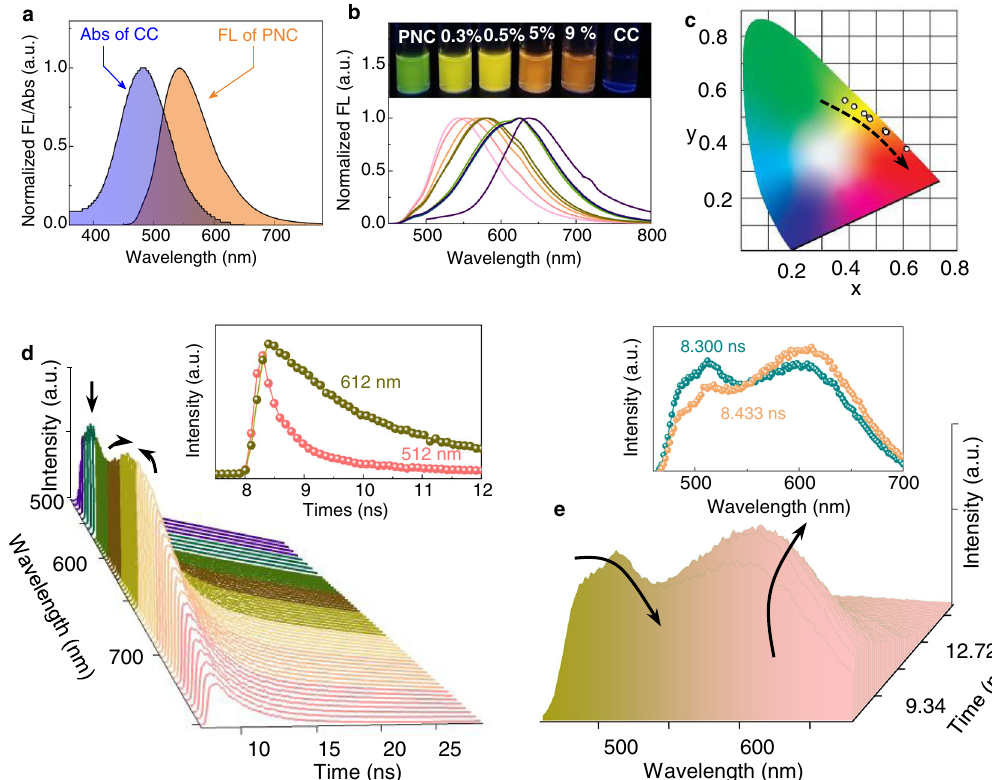
Fig. 3 Optical properties of assemblies upon THF/H2O = 1/9 (v/v). a Normalized spectrum overlaps of donor emission (10 − 4 M) and acceptor absorption (10 − 4 M, excited at 430 nm). b Normalized fl uorescent spectra of PNC (10 − 4 M) with various amount of CC (from left to right: 0, 0.1, 0.3, 0.5, 0.7, 3, 5, 7, 9 mol%, excited at 430 nm) and CC (9 × 10 − 6 M, excited at 480 nm). Insets show the pictures under 365 light irradiation (from left to right: 0, 0.3, 0.5 mol%, 5, 9 mol% and CC) and c corresponding CIE coordination evolution. d Fluorescent decay curves of PNC/CC ([CC] = 5 × 10 − 7 M). Inset shows fl uorescent decay curves of PNC/CC at emission wavelengths of 512 and 612 nm. e TRES of PNC/CC ([CC] = 5 × 10 − 7 M). Inset shows TRES comparison at 8.300, 8.433 ns, respectively. [PNC] = 1 × 10 − 4 M. (excited at 441